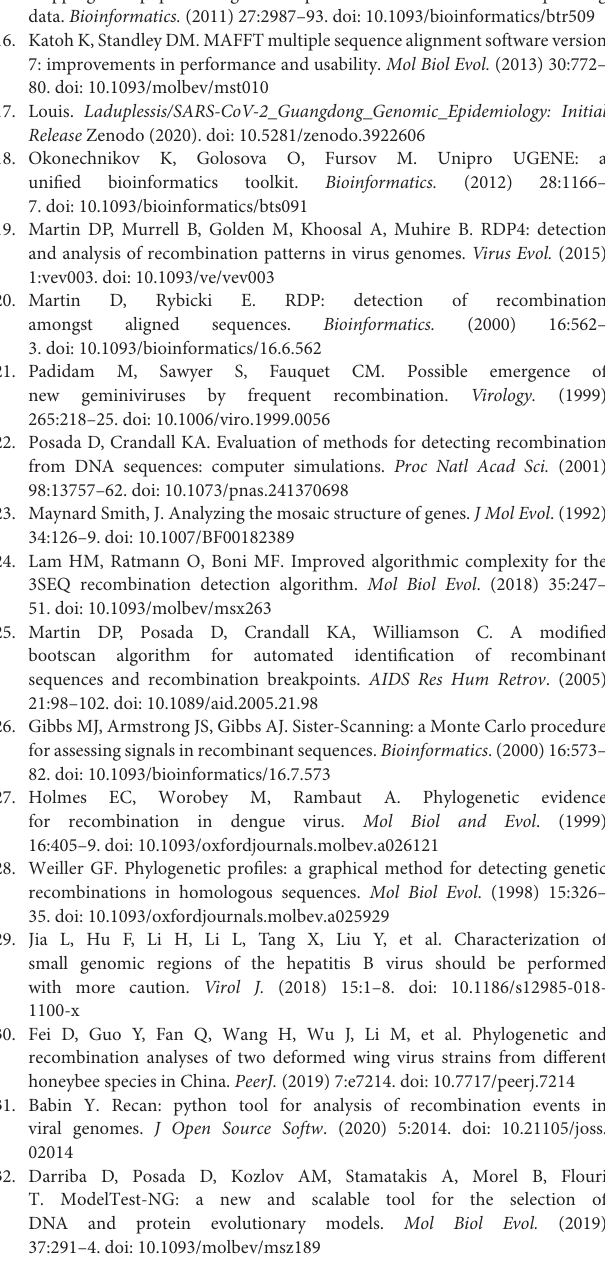
Supplementary File 3 | Collection dates (first occurrence) on GISAID database for SARS-CoV-2 mutations identified in the forty-four sequenced genomes from this study.